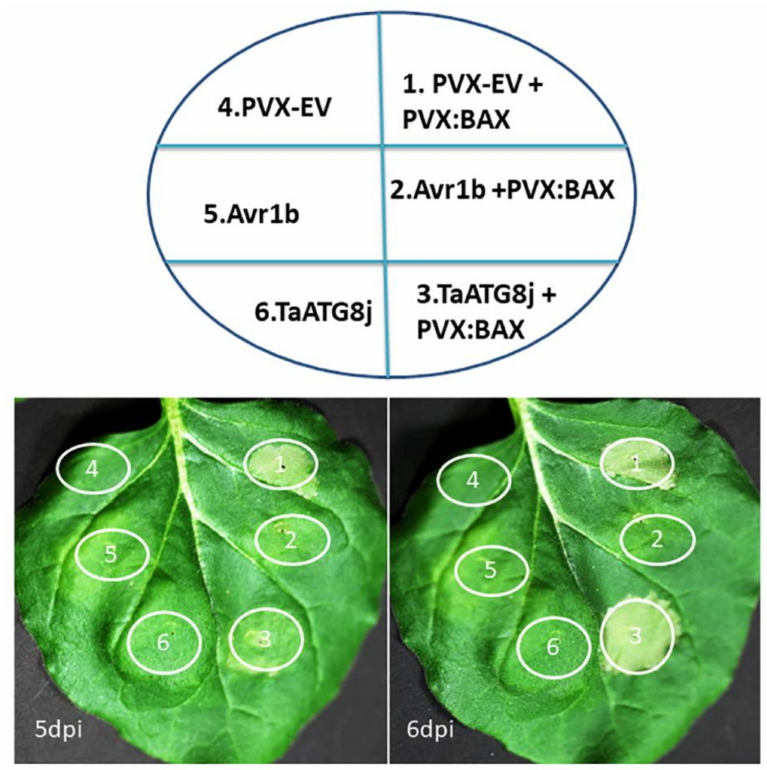
Figure 5. The transient overexpression of TaATG8j in N. benthamiana ( Nicotiana benthamiana ). Transient overexpression of TaATG8j suppressed the programmed cell death induced by the PVX-BAX gene. The N. benthamiana leaf was infiltrated with Agrobacterium tumefaciens cells carrying TaATG8j (circles 3 and 6), Avr1b (circles 2 and 5) or EV (circles 1 and 4). Photographs were taken at 5 and 6 days after the second infiltration (the second infiltration was done only in circles 1, 2 and 3 at 24 h after the first infiltration using A. tumefaciens carrying PVX:BAX ). The circular areas indicate the infiltrated